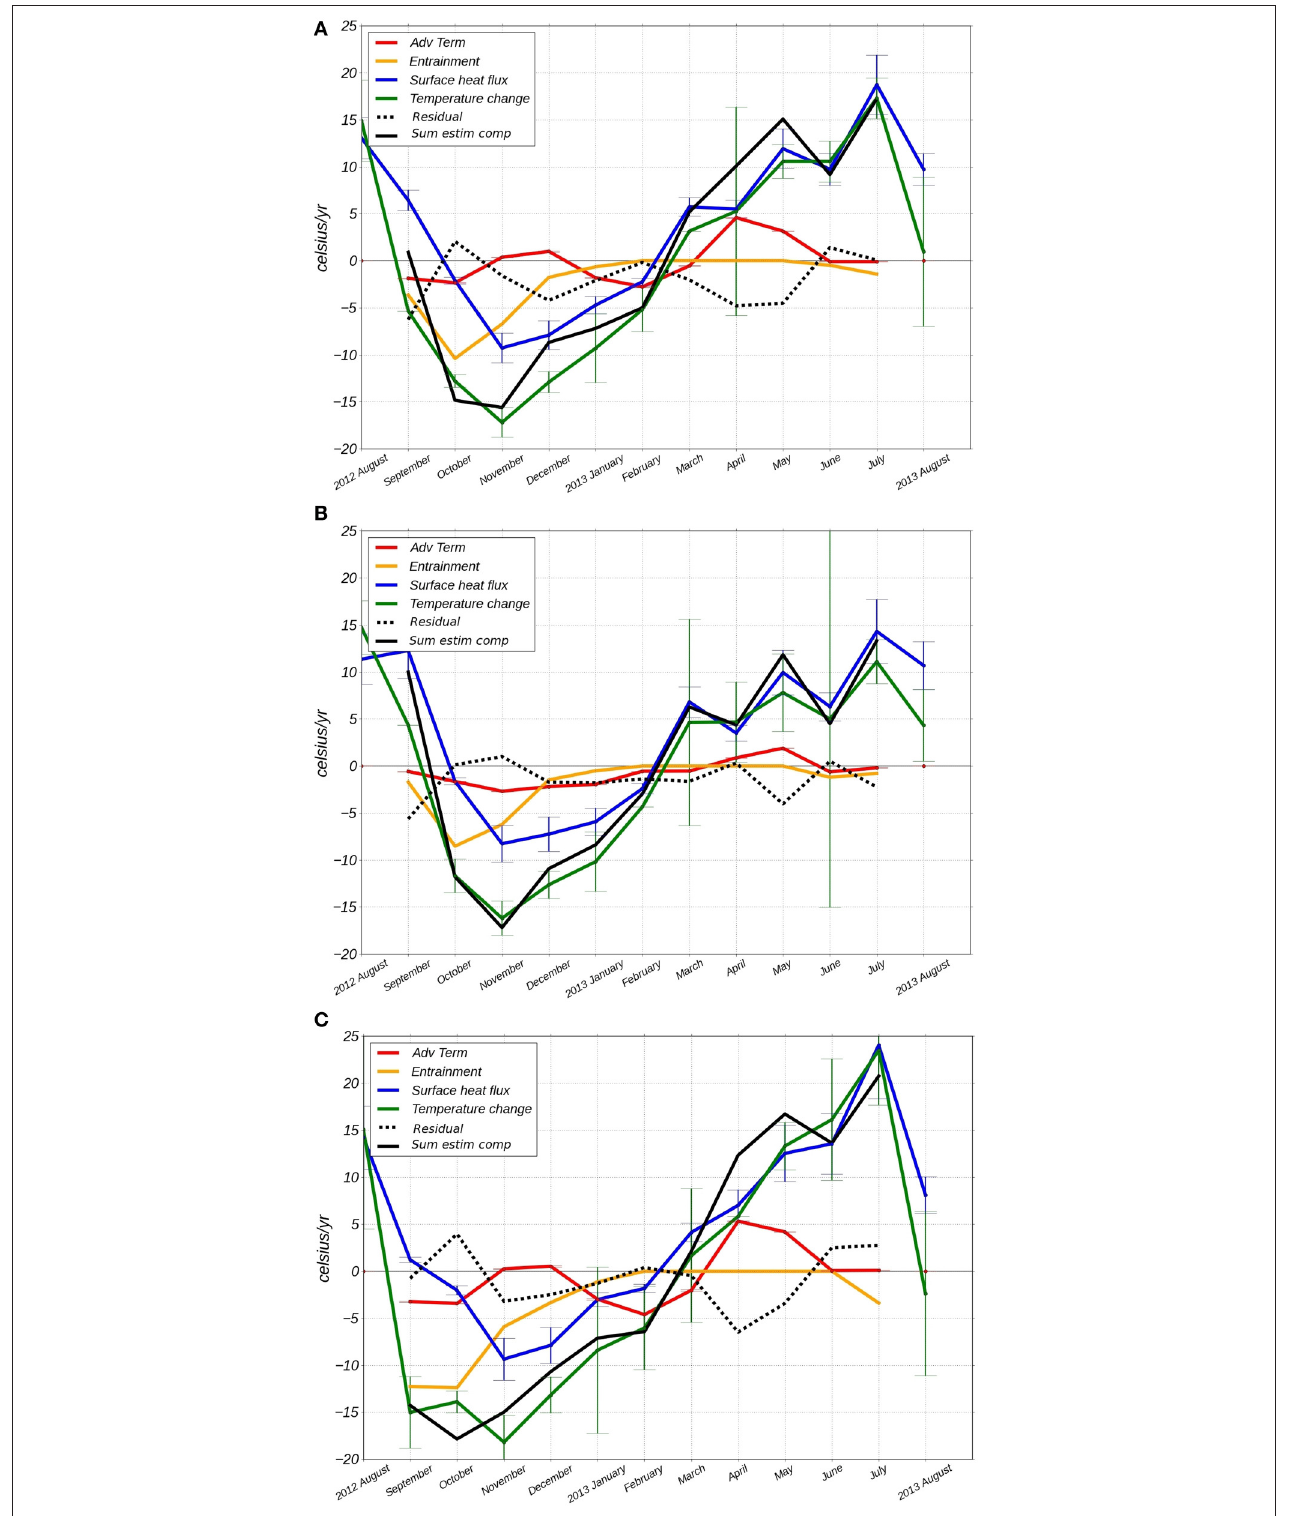
FIGURE 12 | Components of temperature budget for the period August 2012–2013, residual (black dashed curves) and the sum of all estimated components of the right side of the Equation (2). (A) —total considered region; (B) —southern part 21 ◦ –25 ◦ N; (C) —northern part 25 ◦ − 30 ◦ N.